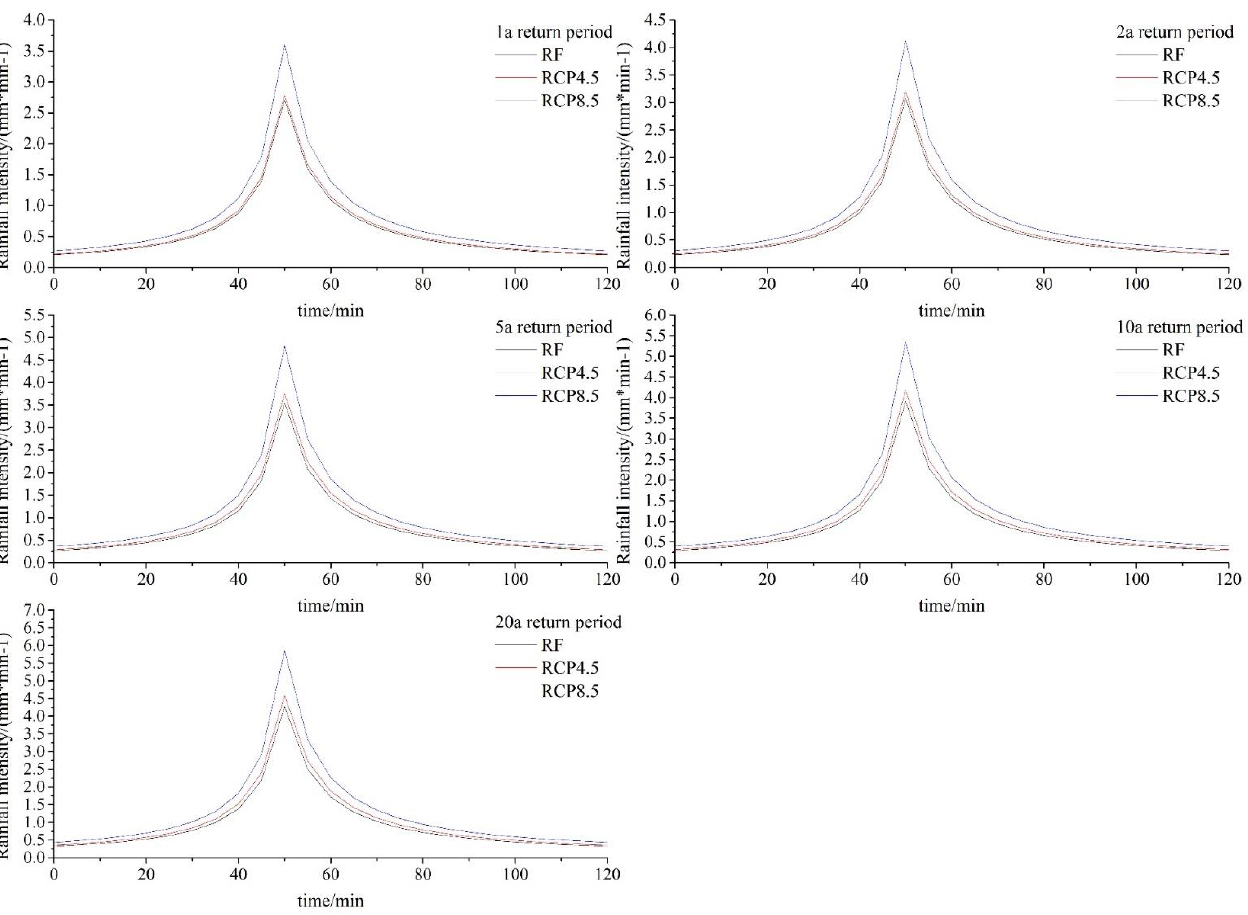
Figure 2. The Chicago hyetograph shapes of rainstorm lasting 120min with different return periods under RF, RCP4.5, RCP8.5 scenarios.